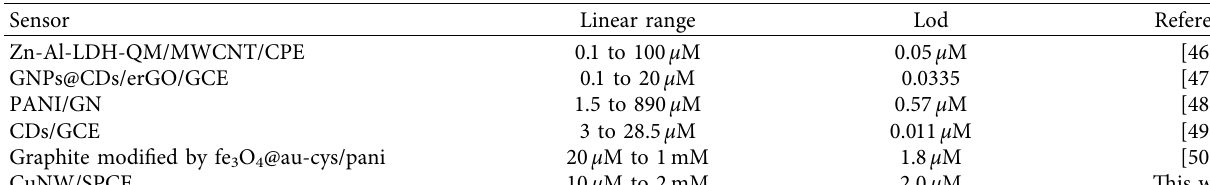
Table 1: Comparison of CuNW/SPCE with previously reported uric acid sensors.